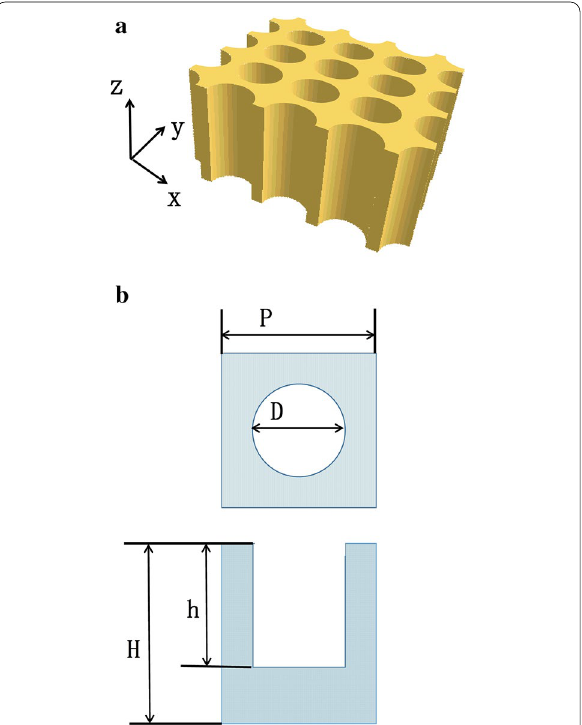
Fig.1 Schematic of nanoholes-structured perovskite/silicon tandems cells used in the model